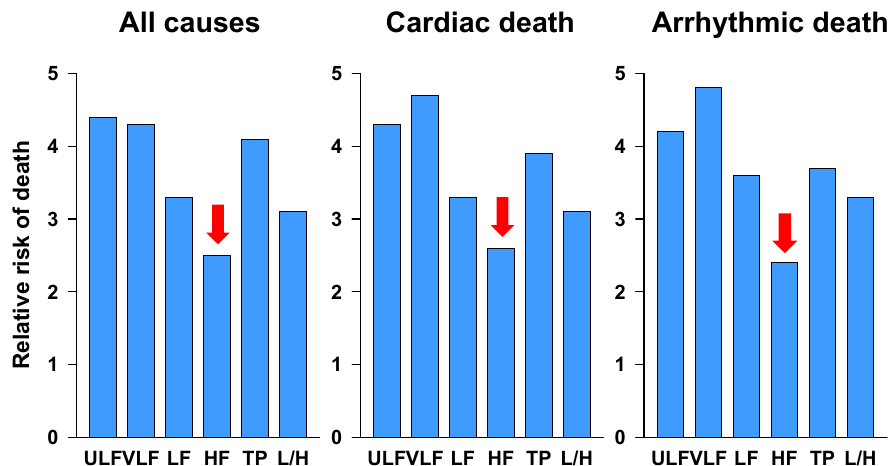
Figure 2. Relative risk of death predicted by the decrease in HRV frequency components. L/H = LF to HF ratio in power, TP = total power, ULF = ultra-low-frequency component (<0.003 Hz), VLF = very-low-frequency component (0.003–0.04 Hz). Made from Table 2 in reference [2] .